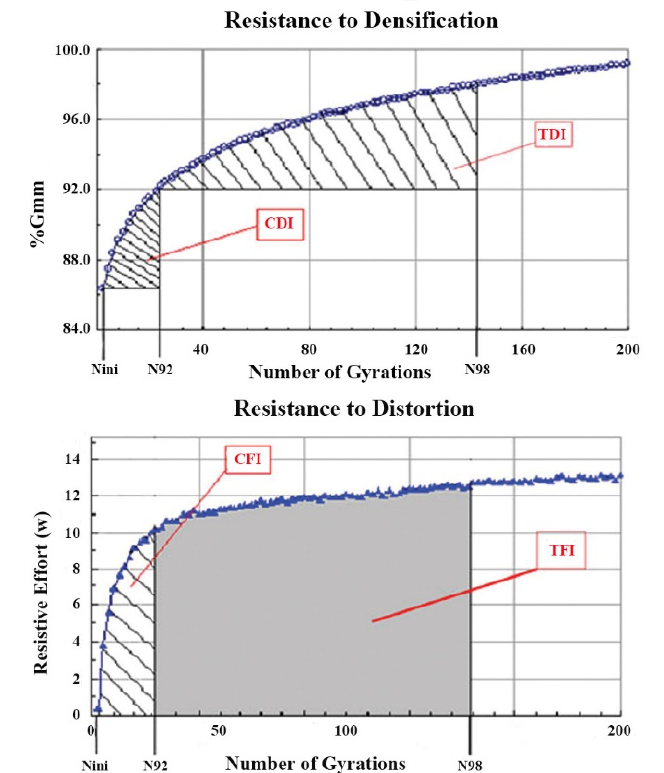
Figure A1. Densification indexes for mix resistance to densification and Traffic indexes for mix resistance to distortion.